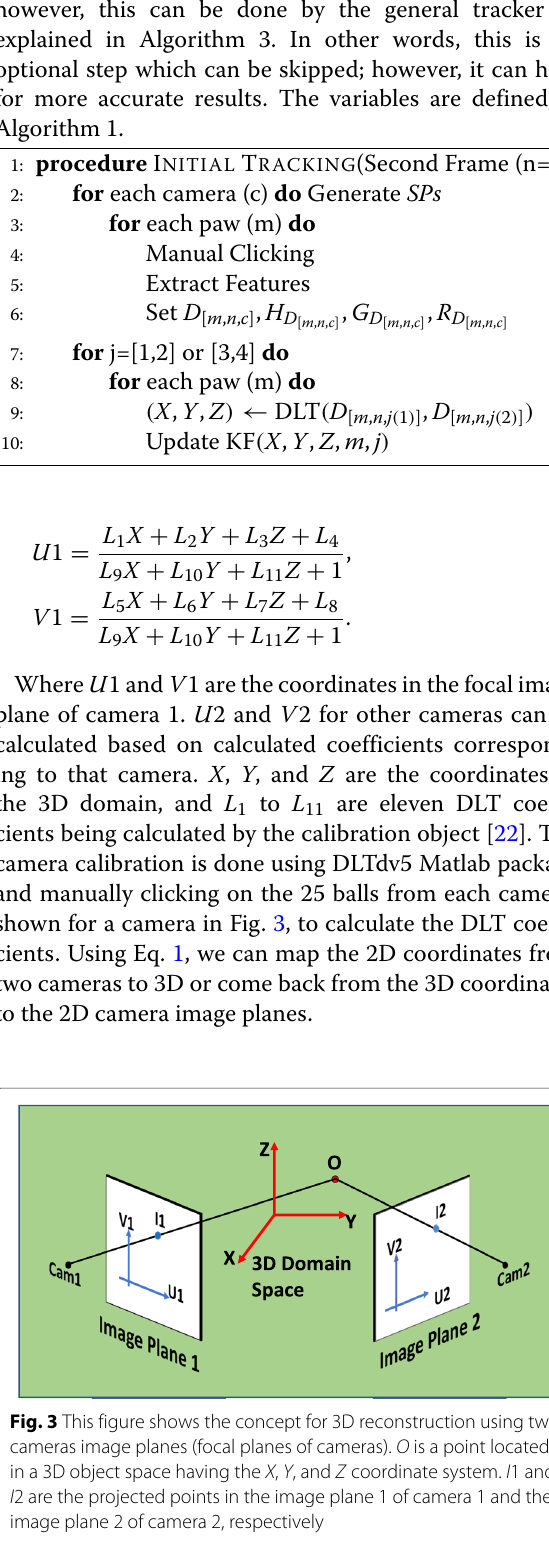
Algorithm 2 The second frame tracking algorithm.